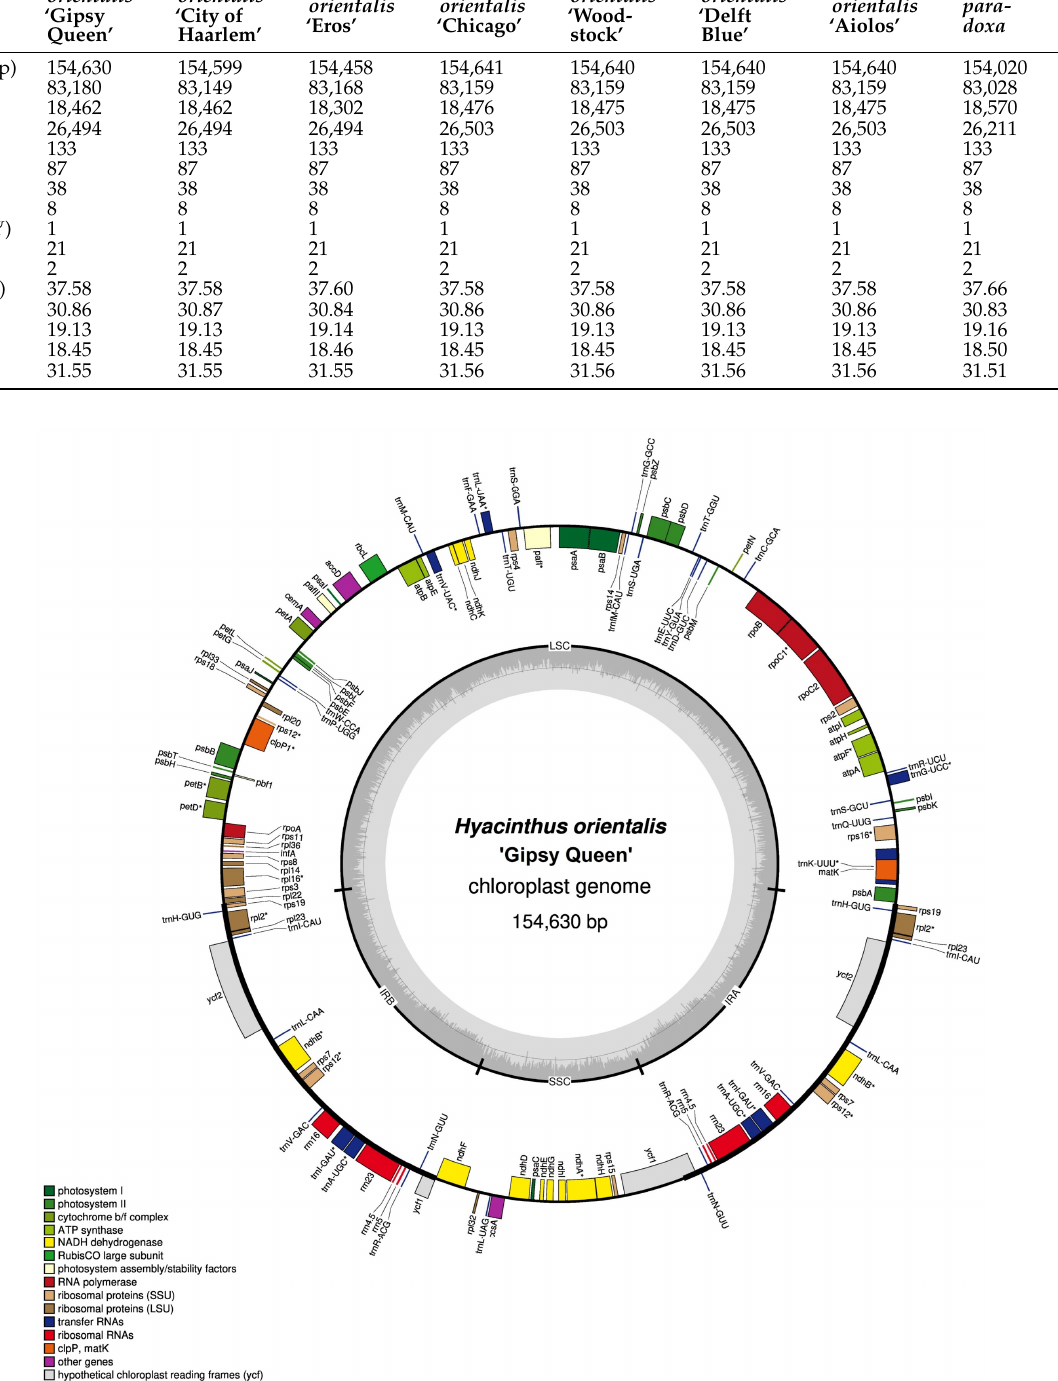
Figure 3. Chloroplast genome map of Hyacinthus orientalis L. ‘Gipsy Queen’. Intron-containing genes were asterisked (*).